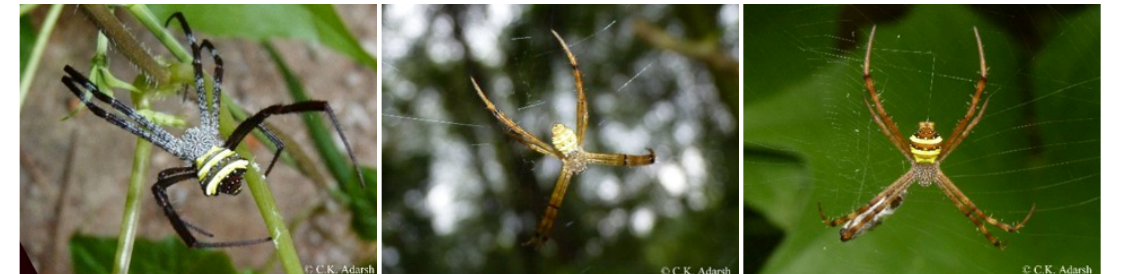
Image 4. Argiope anasuja Image 5. Argiope catenulata Image 6. Argiope pulchella